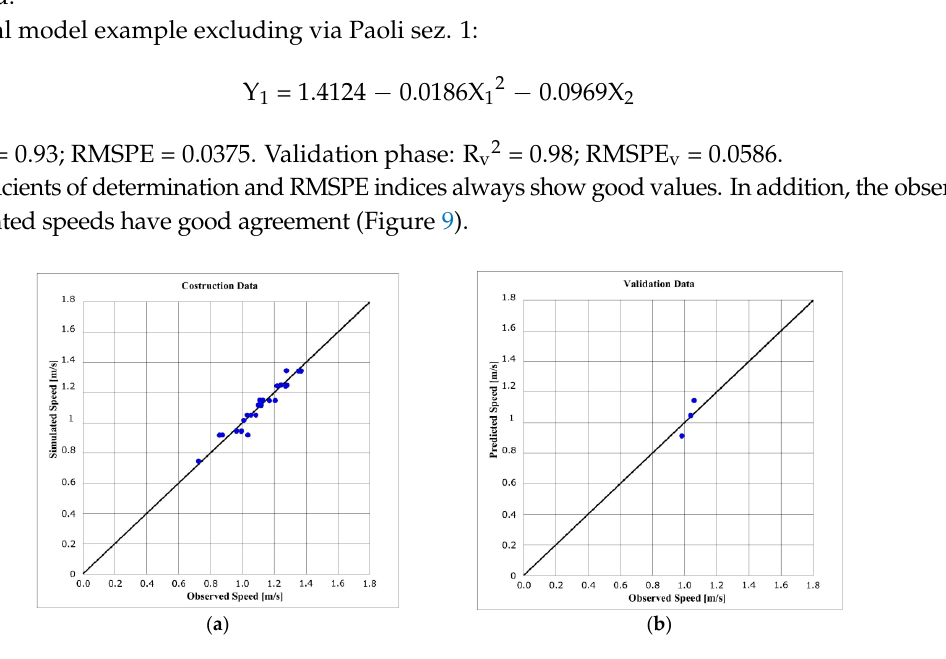
Figure 8. Global model. Comparison between the observed and simulated speeds.